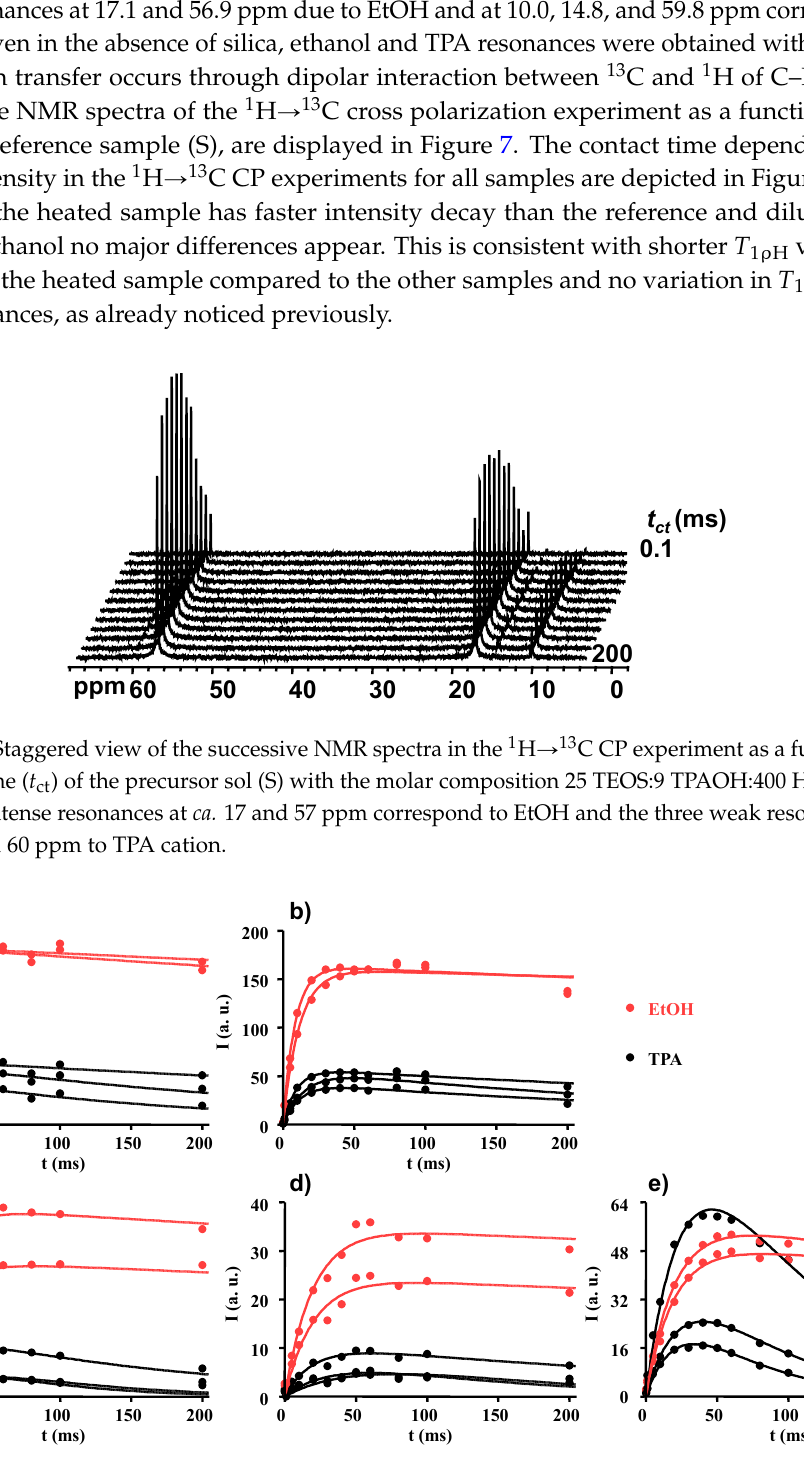
Figure 8. Contact time dependency of the resonance intensity of ethanol and TPA in the 1 H → 13 C CP experiments for samples without Si content ( a ) S0; and ( b ) SD0; and with Si content ( c ) S; ( d ) SD; and ( e ) SH. The solid lines represent least-square fits of the experimental data using Equation (5) ( I = ( I 0C /(1 − ( T CH / T 1 ρ H )))·(exp( − t / T 1 ρ H ) − exp( − t / T CH ))).